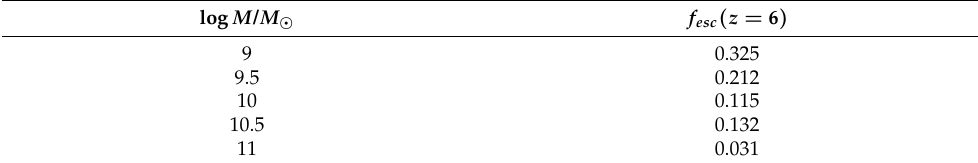
Table 5. Table from Yajima et al. (2011) [57] with dependence between escape fraction and